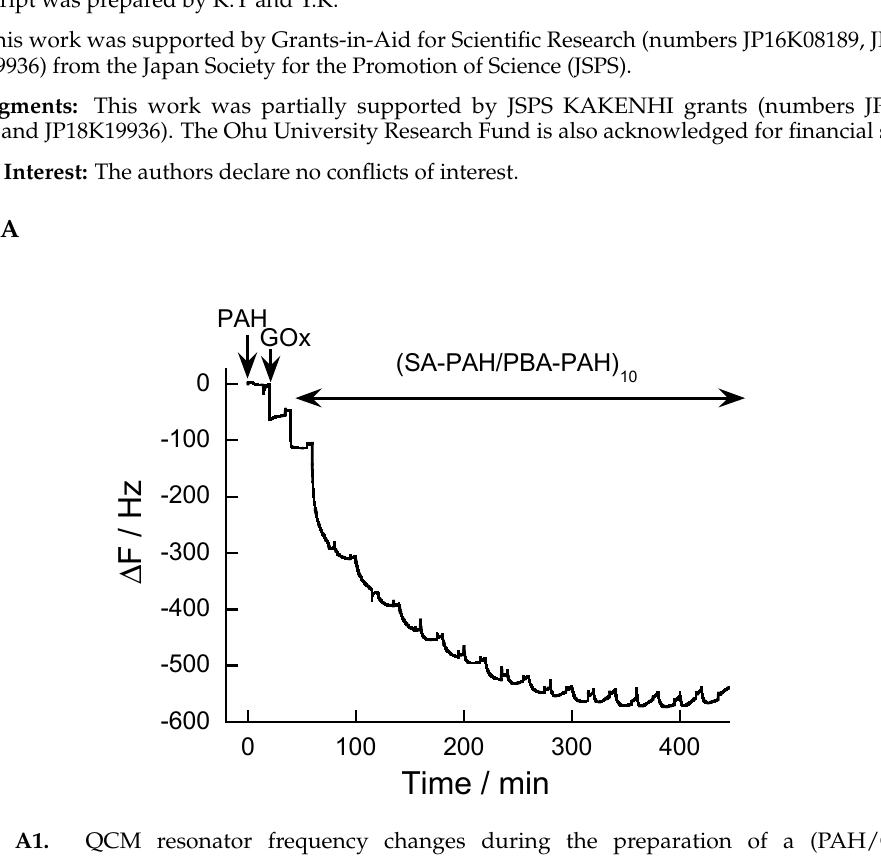
Figure A1. QCM resonator frequency changes during the preparation of a (PAH/GOx) (SA-PAH/PBA-PAH) 10 film in a 10 mM HEPES buffer (pH 7.4) in the presence of 150 mM NaCl.